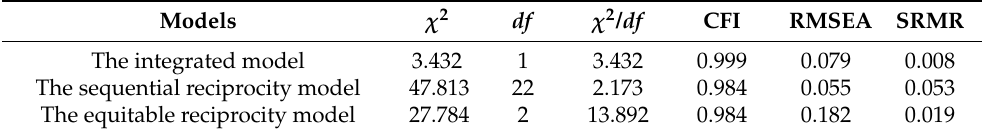
Table 3. Absolute fit indices of the three tested